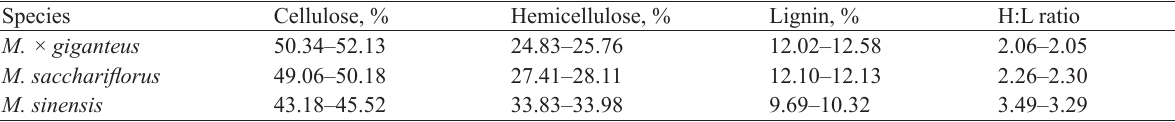
Table 1 Composition of miscanthus species cell walls Species Cellulose, % Hemicellulose, % Lignin, % H:L